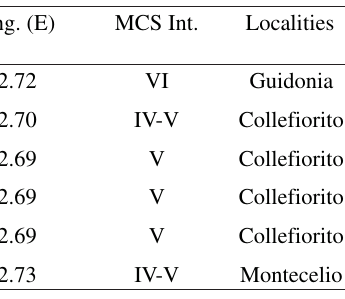
Table I. The most important events on which we have macro-seismic